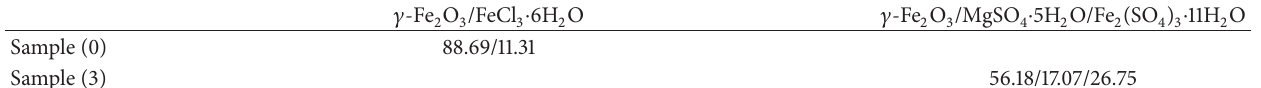
Table 4: Volume percentages of phases ( Φ 𝑖 ) in samples ( 0 ) and ( 3